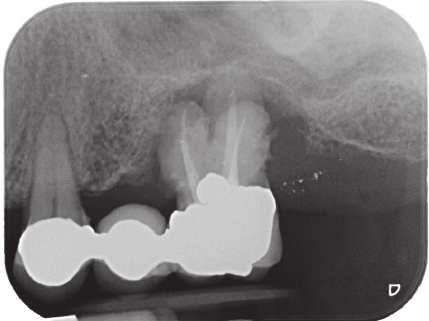
Figure 2: Intraoral radiograph at the patient presentation. Tooth 26 is affected by an endoperiodontal lesion and is lost.